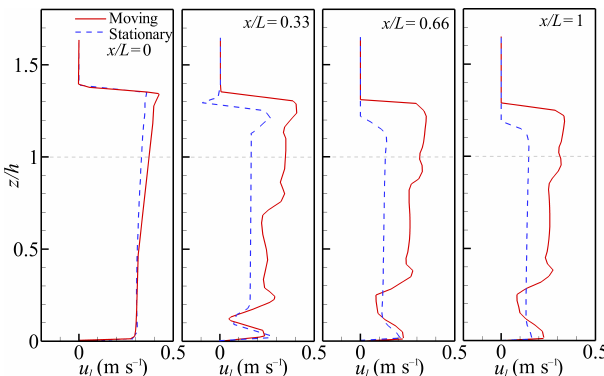
Figure 10. Comparison of the horizontal velocity profile for mov- ing and stationary cylinders as wave crest passes each section, H i =